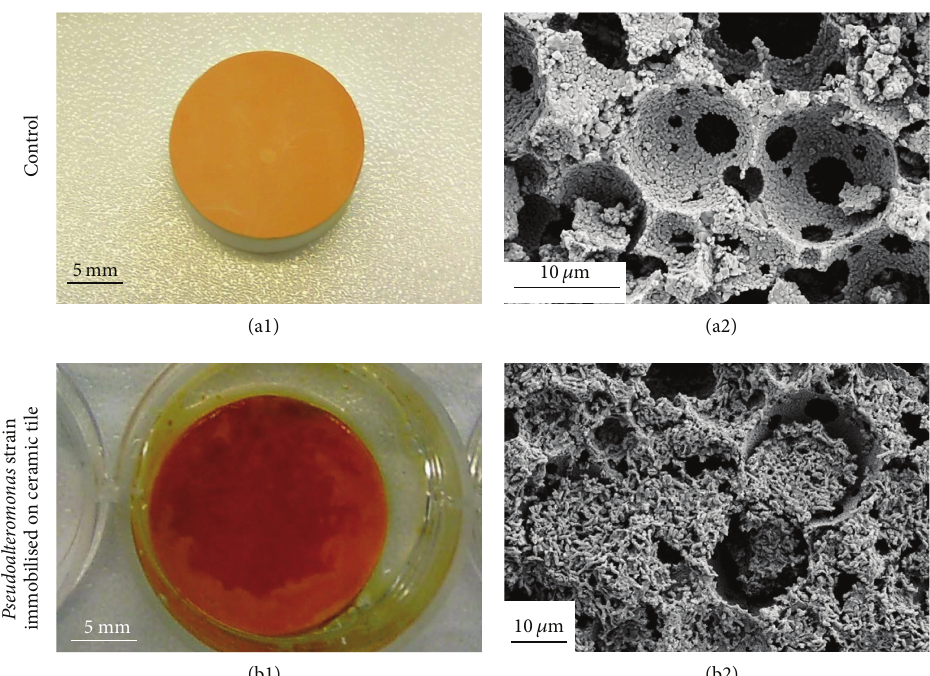
Figure 4: Biofilm formation of the Pseudoalteromonas sp. strain on a ceramic tile. Ceramics were photographed immediately after the incubation period needed for biofilm formation [20], prior to starting the competition experiment with V. anguillarum . The orange-coloured biofilm (b1) is typical for strain MLms gA3. In parallel SEM analysis revealed the presence of rod-shaped bacteria. The caves of the tiles are filled cells displaying a length of ∼ 2 𝜇 m and a width of ∼ 1 𝜇 m (corresponding to the known size of Pseudoalteromonas with 1 𝜇 m × 2-3 𝜇 m, [21]). A blank ceramic tile incubated in MB-starch served as a control ((a1) and (a2)).